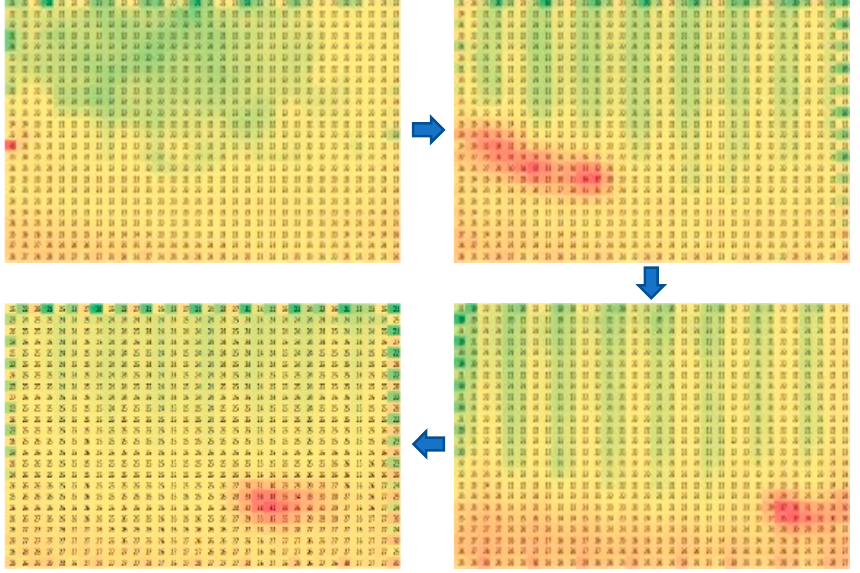
Figure 8. Experiment conducted at a distance of 20 m from the heat source, moving at 30 km/h. Sequence of four images targeting the heat source: 1st (top ‐ left), 2nd (top ‐ right), 3rd (bottom ‐ right) and 4th (bottom ‐ left).